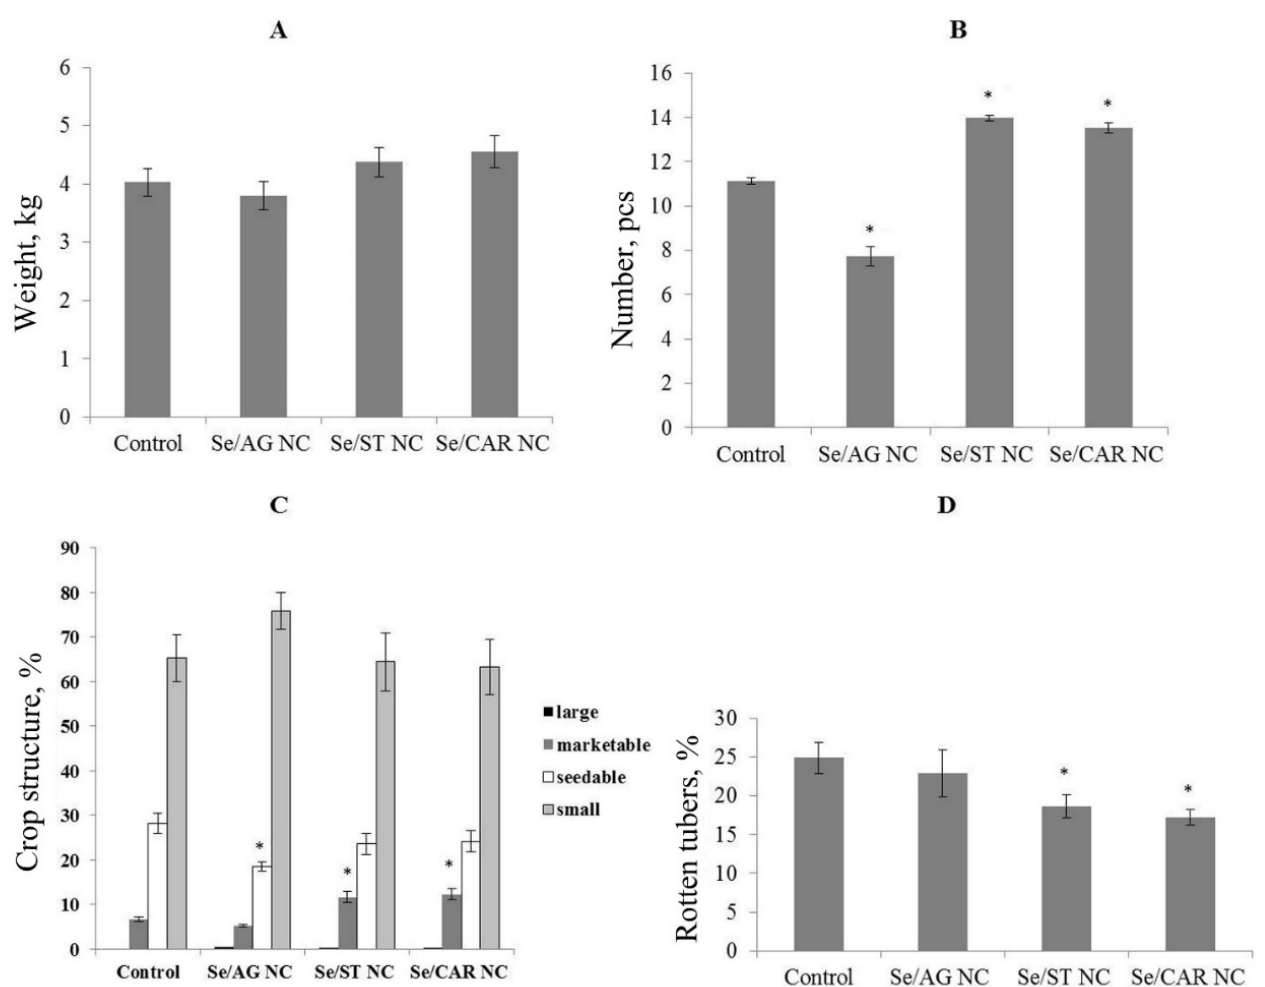
Figure 6. Effect of treatment of potato tubers with selenium (Se) nanocomposites (NCs) on the mean weight of tubers per plant obtained from plants in the second generation ( A ), their number ( B ), yield structure ( C ), and percentage of rotten tubers ( D ) in comparison with control; * Significant differences from control, p < 0.05 based on Mann–Whitney U test. Se/AG NC, Se/ST NC and Se/CAR NC are arabinogalactan-, starch- and kappa-carrageenan-based Se nanocomposites. Table 5. Analysis of biomass of potato tubers in the second-generation tubers obtained from plants grown from parental tubers treated with selenium (Se) nanocomposites (NCs). Trait Control Total tuber weight, g (based on 20 plants) Median tuber weight, g